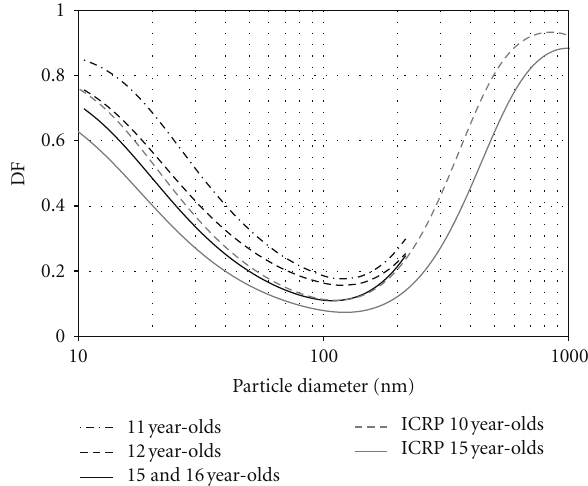
Figure 3: Measured and modeled deposition fraction curves by age for non-asthmatics. The curves suggest a strong e ff ect of age on deposition. Age was used as a covariate in the ANCOVA analysis for total deposited fraction. Note reasonable agreement between our measurements and the ICRP model